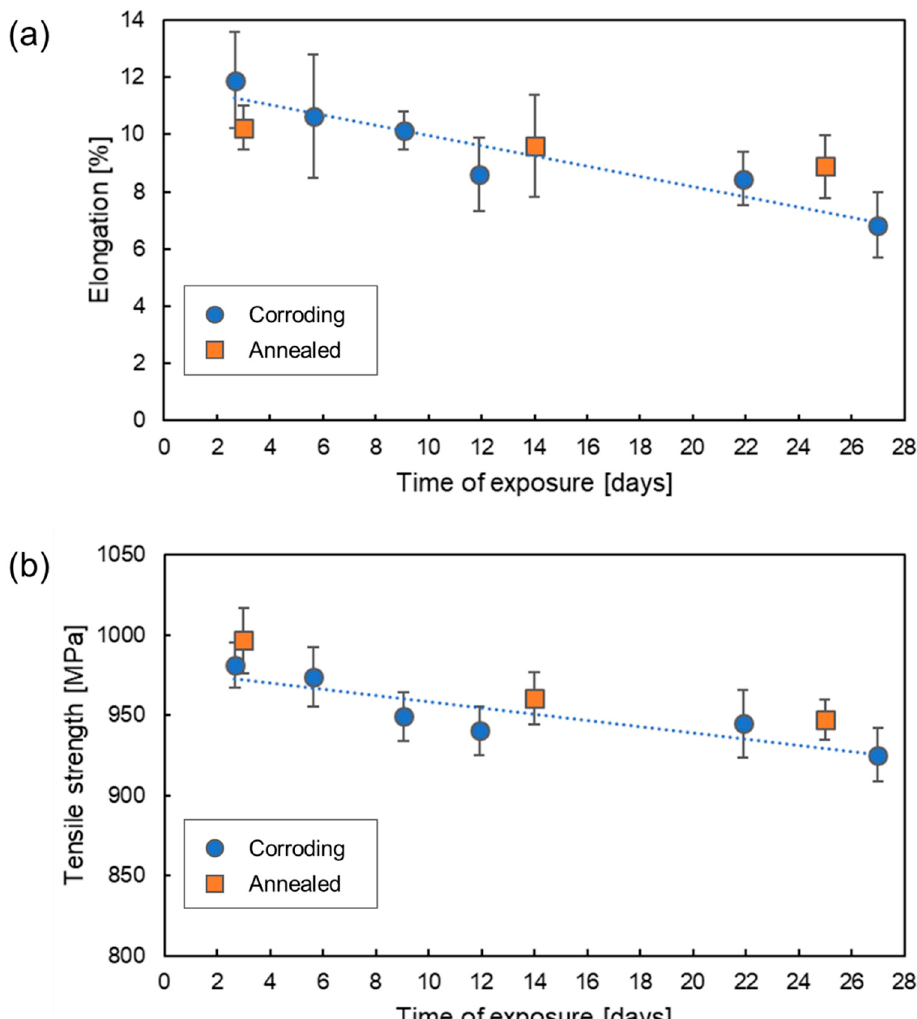
Figure 5. Change in elongation ( a ) and tensile strength ( b ) with time of exposure of DP1000 AHSS with NaCl deposits in humid air at 85% RH.